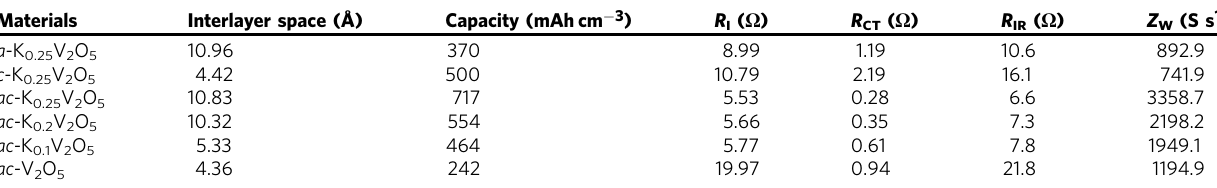
spacing directly decreasing to 4.36 Å as a consequence of squeezing out the crystal water at 200 °C (Table 1, Supplementary Figs. 5, 6) 38,40,44 . This observation is in sharp contrast with the ac -K x V 2 O 5 , demonstrating the signi fi cant role of the amorphous K 0.25 V 2 O 5 · n H 2 O as molecular pillars in maintaining large interlayer spacing. Owing to the decrease of the hydrated K + pillars, the interlayer spacing of ac -K x V 2 O 5 decreases with the K + concentration (Table 1, Supplementary Fig. 7). Electrochemical characterizations . The electrochemical mea- surements of NP Au/K x V 2 O 5 microelectrodes are performed in 0.5 M K con fi guration with a Pt foil as the counter electrode and an Ag/ AgCl electrode as the reference electrode. Figure 3a shows typical cyclic voltammograms (CVs) of NP Au/K x V 2 O 5 ( x = 0.25) microelectrodes within a voltage window of − 0.8 to 0 V (versus